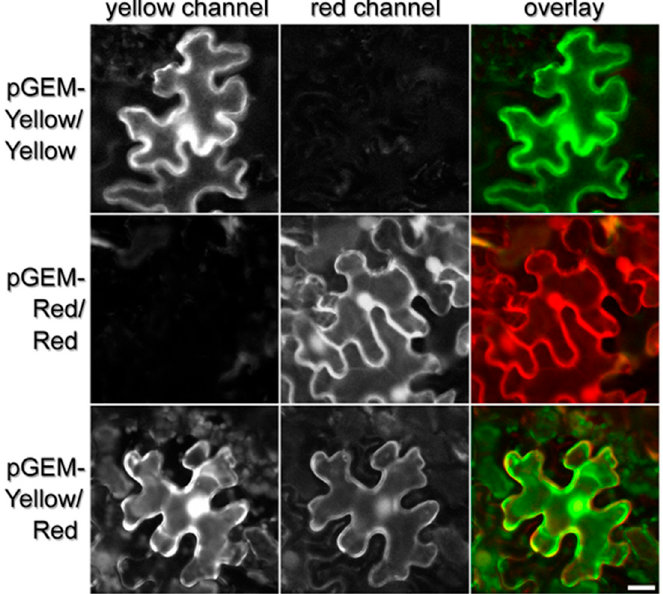
Figure 2. Confocal sections of the lower epidermis of N. benthamiana leaves, 5 days post-inoculation. Rows show the different pGEMINI constructs as indicated, while columns show images acquired in the yellow ( left ) and red channel ( right ). The scale bar represents 20 μ m. Image size was 1024 × 1024 pixels, with a resolution of 6.77 pixels per μ m. No offset was used, and the scan speed was ¼ frames/s (galvano scanner). Pinhole size was set to 1.2 times the Airy disk size of the 1.4 N.A. objective at 525 nm. Scanner zoom (3.0) was centered on the optical axis to minimize aberrations.